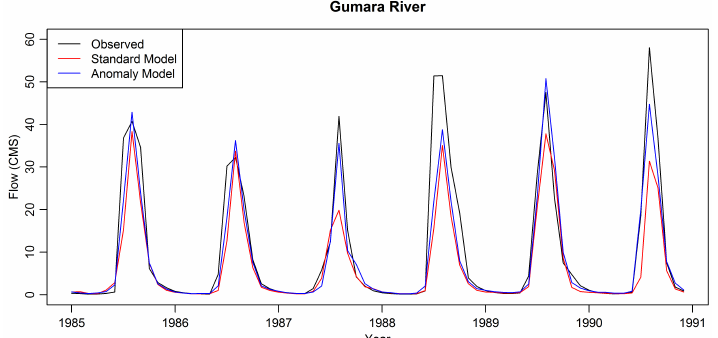
Figure 3. Example observed and predicted flows from the standard-formulation RF model and anomaly-formulation M5 model for the Gumara River from 1985 to